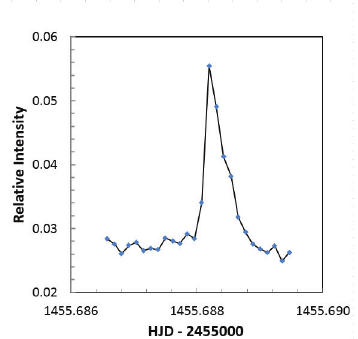
Figure 6: Photometry of a burst that occurred on June 12, 2013. The intensity, compared to star C in Figure 1 of Hakala et al. (1998), of this typical burst rises to peak in 10-20 s and declines in about 50